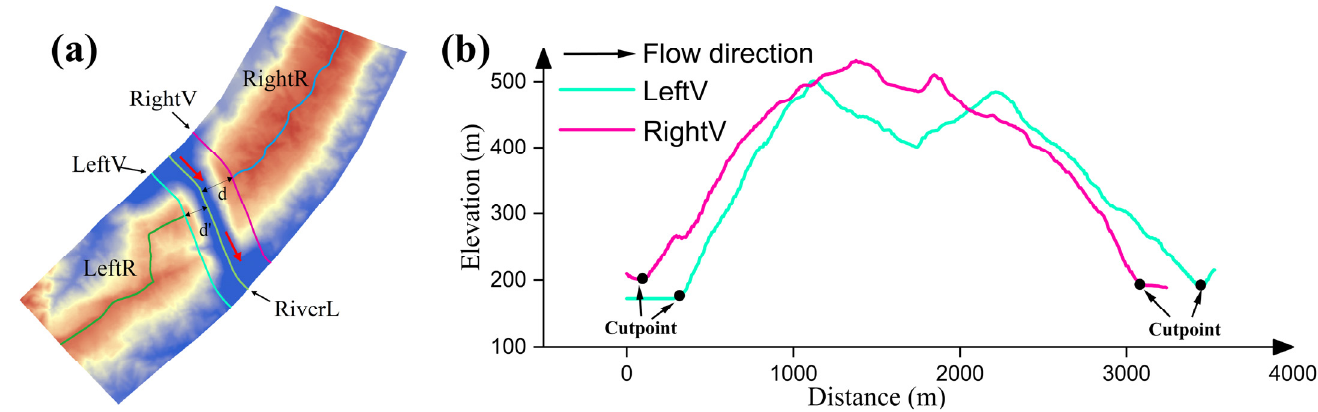
Figure 8. ( a ) Extraction of the boundary lines on both sides of C4 by the construction of a buffer zone. LeftV indicates the left boundary line, RightV the right boundary line, RiverL the river center line, d and d’ the buffer distance, and the black arrow the river flow direction. ( b ) The stack profile of C4’s boundary lines and the Cutpoint divides at a split point.